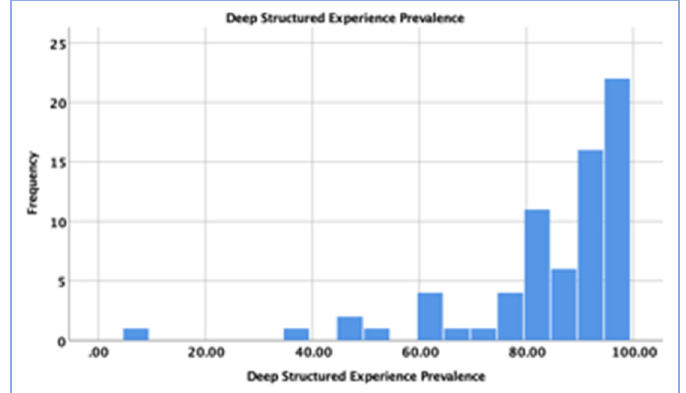
Figure 2. Distribution of Deep-Structured Experience Scores